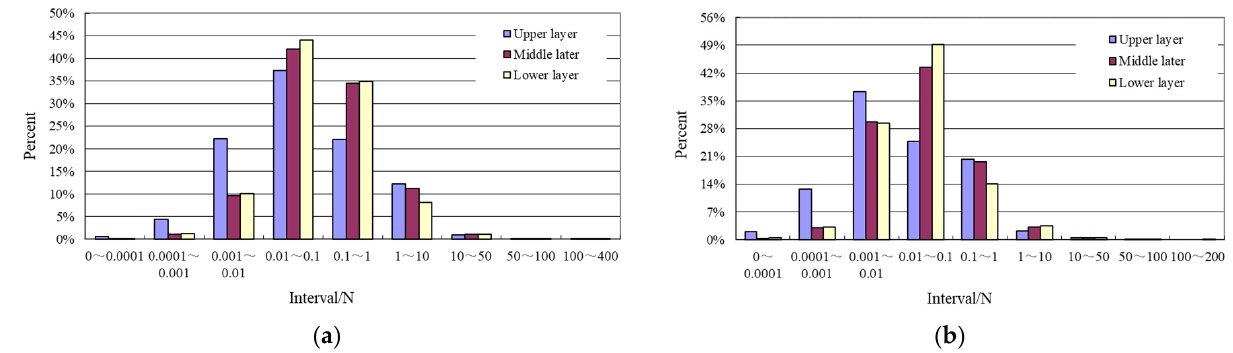
Figure 5. Diagram of distribution frequency of the contact forces in each asphalt layer. ( a ) Normal contact force. ( b ) Tangential contact force.